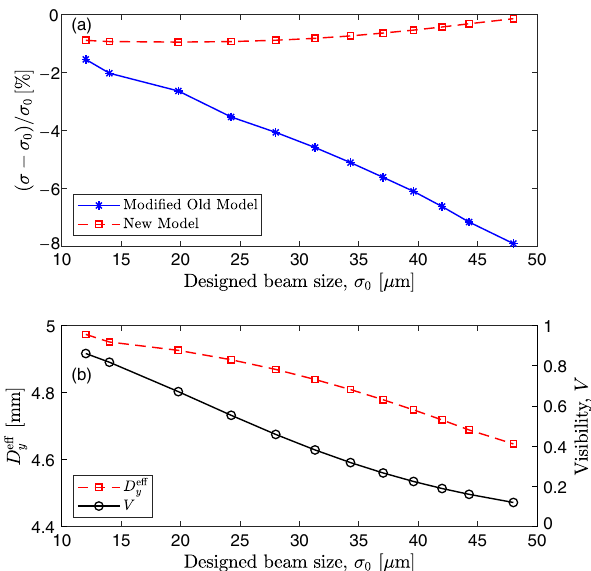
FIG. 7. Simulation results using a double slit with a fixed slit separation and a fixed slit opening for beams with varying sizes. (a) The relative difference between the fit beam size and the actual beam size. The blue solid line is the result of the old modified model and the red dashed line is the result of the new model. (b) The effective separation D eff and the visibility V extracted y from the fit parameters using the new model. The beam energy is ¼ 5 mm, d ¼ 2 mm, L ¼ 2 m, L ¼ 2 m, and a 1000 MeV, D 1 2 y 340-nm wavelength filter is used in the